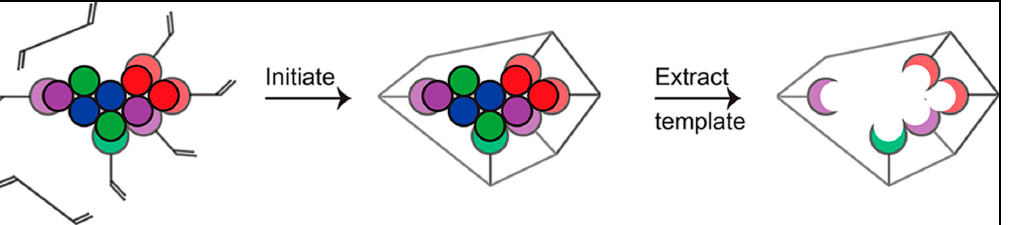
Figure 2. General process of imprinting. Reprinted with permission from reference [30]. Copyright 2017 American Chemical Society.